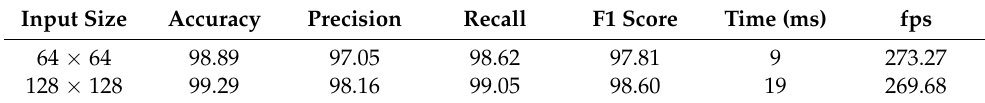
Table 5. Contrast of input sizes of 16,384 pixels (128 × 128) and 4096 pixels (64 ×